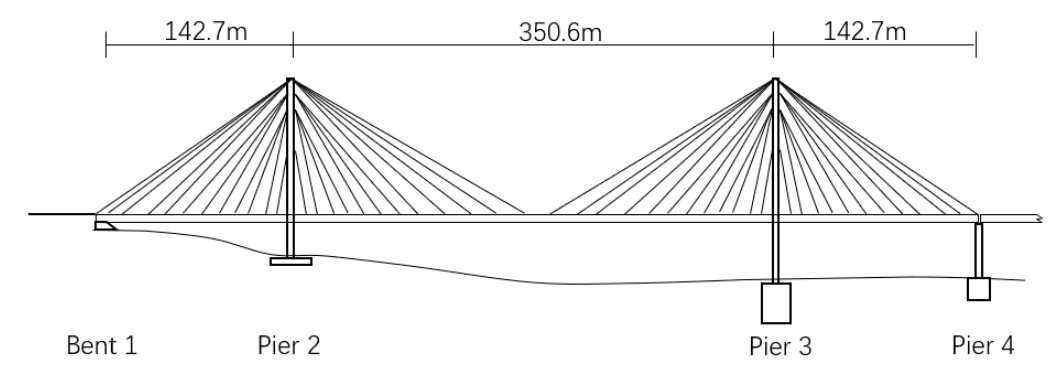
Figure 13. Simplified drawing of Bill Emerson Memorial Bridge.